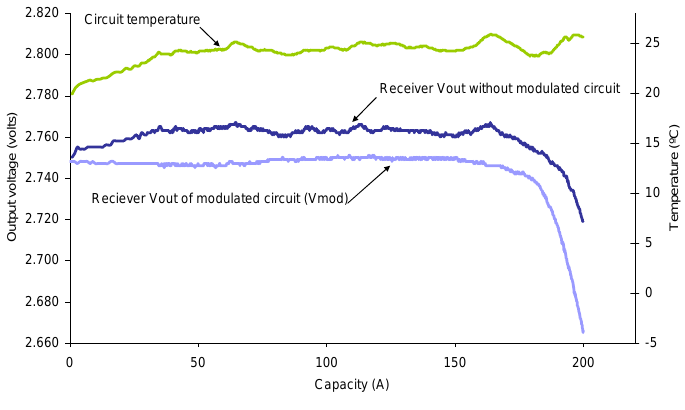
Figure 11. Compensation of temperature in the receptor by means of